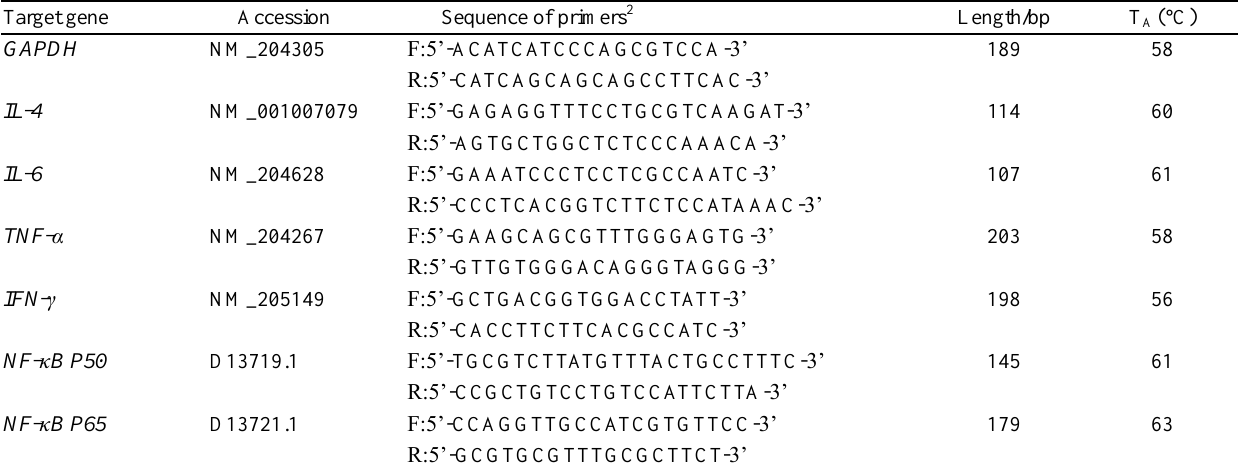
Table 2. Primer pairs of chicken genes related to intestinal immunity and oxidative stress Target